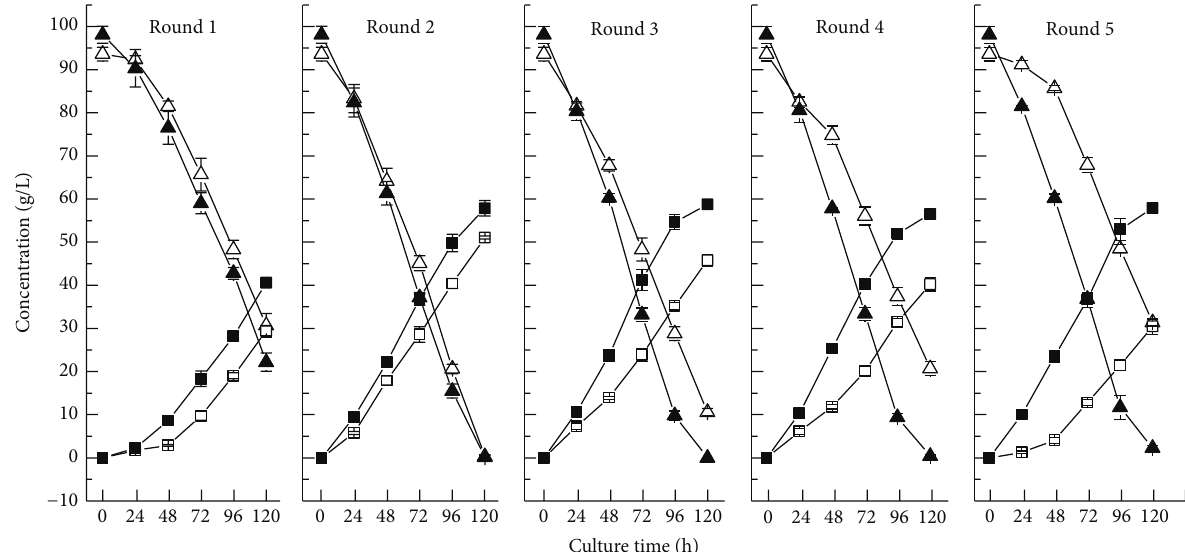
Figure 3: Xyloseconsumption and xylitol yield inrepeated batch fermentation forxylitol production by immobilized wholecell fromcorncob acid hydrolysate via SAA pretreatment and two-step adsorption detoxification ( 󳵳△ residual xylose, ◼◻ xylitol yield; solid symbols refer to SAA pretreatment method, and hollow symbols refer to adsorption